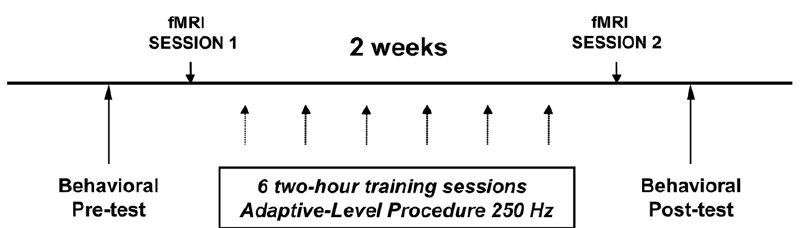
Figure 3. General timeline for all testing and training sessions. At the beginning of the experiment, all subjects were tested with singing and auditory discrimination tasks. A few days later, the experimental group (designated for auditory training) performed a subset of these tasks again in the MR scanner. Following the scanning session, the experimental group received six sessions of auditory discrimination training spread across two weeks. The experimental subjects were scanned again, performing the same subset of tasks as in the first scanning session. Finally, both the experimental and control groups were tested again with auditory discrimination and singing tasks.